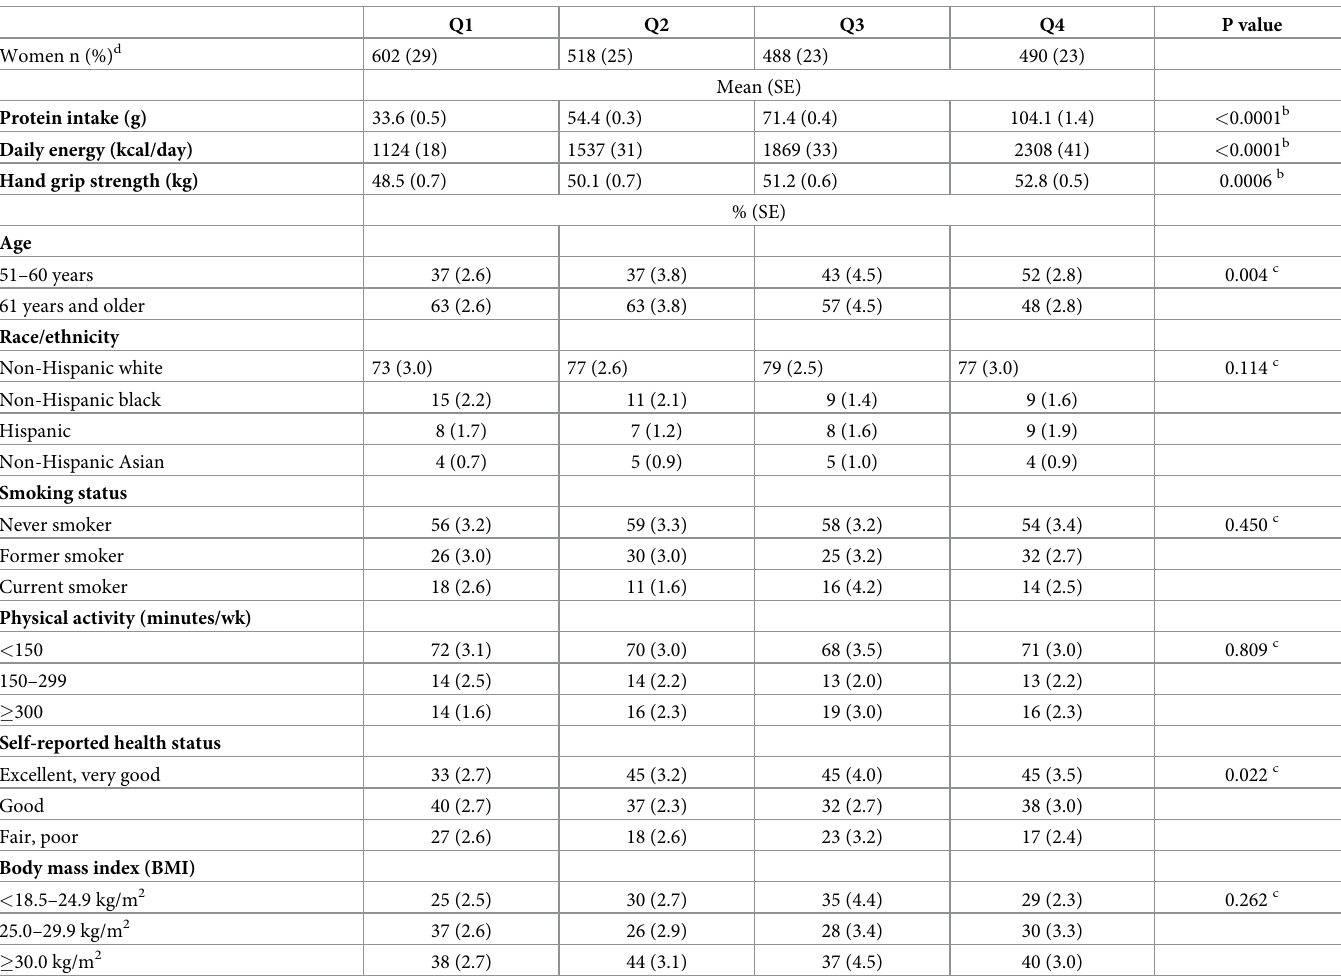
Table 2. Distribution of selected characteristics by daily protein intake quartile in women a